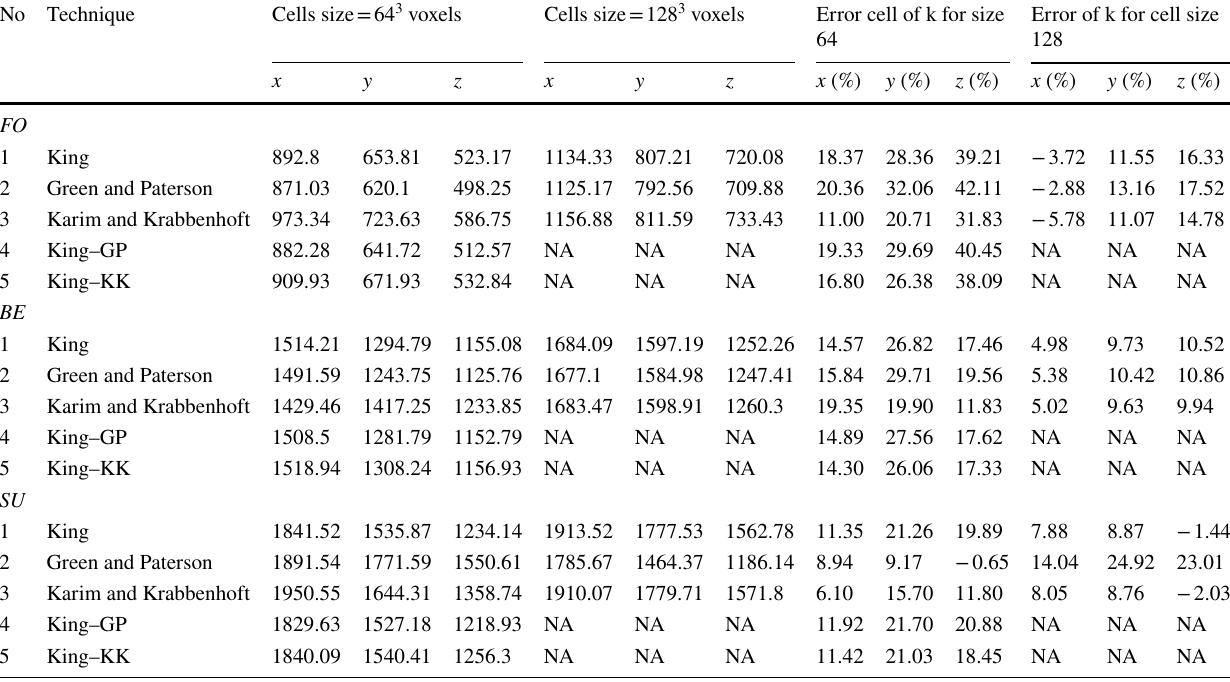
Table 2 Error analysis of all renormalization schemes which are calculated using Eq. 9 No